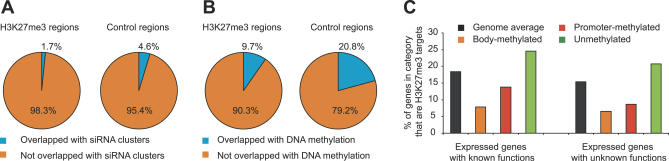
Relationship between H3K27me3, siRNAs, and DNA Methylation(A) The fraction of H3K27me3 regions and random control regions overlapping with siRNA clusters (blue).(B) The fraction of H3K27me3 regions and random control regions overlapping with DNA-methylated regions (blue).(C) The fractions of genes containing body DNA methylation (orange), promoter DNA methylation (red), and no DNA methylation (green) that are H3K27me3 targets. The genome averages of expressed genes are shown for comparison.